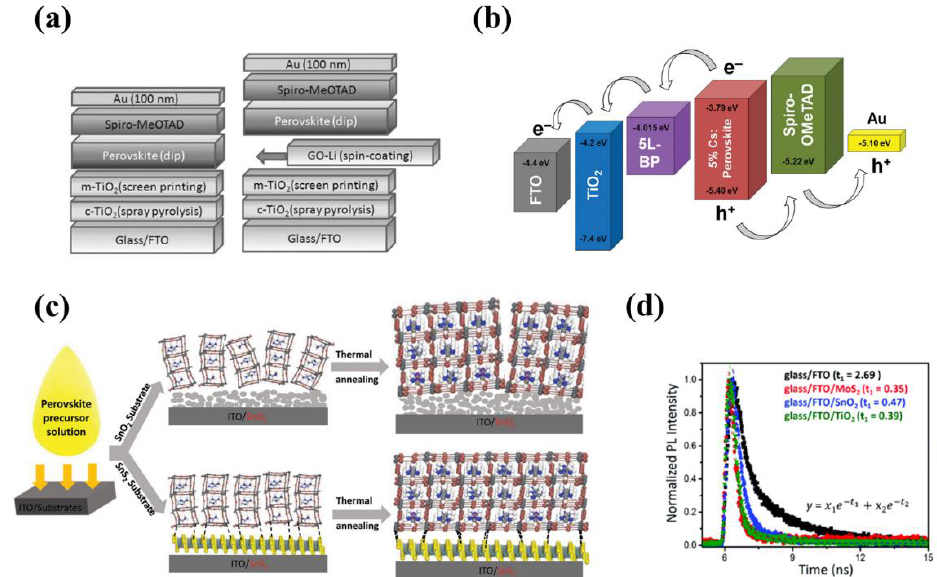
Figure 7. ( a ) Schematic structure of the reference device and GO-Li device. ( b ) Schematic illustration of energy diagram and carrier transfer in the perovskite solar cell. ( c ) The schematic illustration of the formation of perovskite films on SnO 2 and SnS 2 ETLs. ( d ) The TRPL results of perovskite films with different ETLs. ( a ) Reprinted with permission from Ref. [176]. Copyright 2016, WILEY. ( b ) Reprinted with permission from Ref. [177]. Copyright 2019, WILEY. ( c ) Reprinted with permission from Ref. [178]. Copyright 2018, WILEY. ( d ) Reprinted with permission from Ref. [170]. Copyright 2019, RSC.